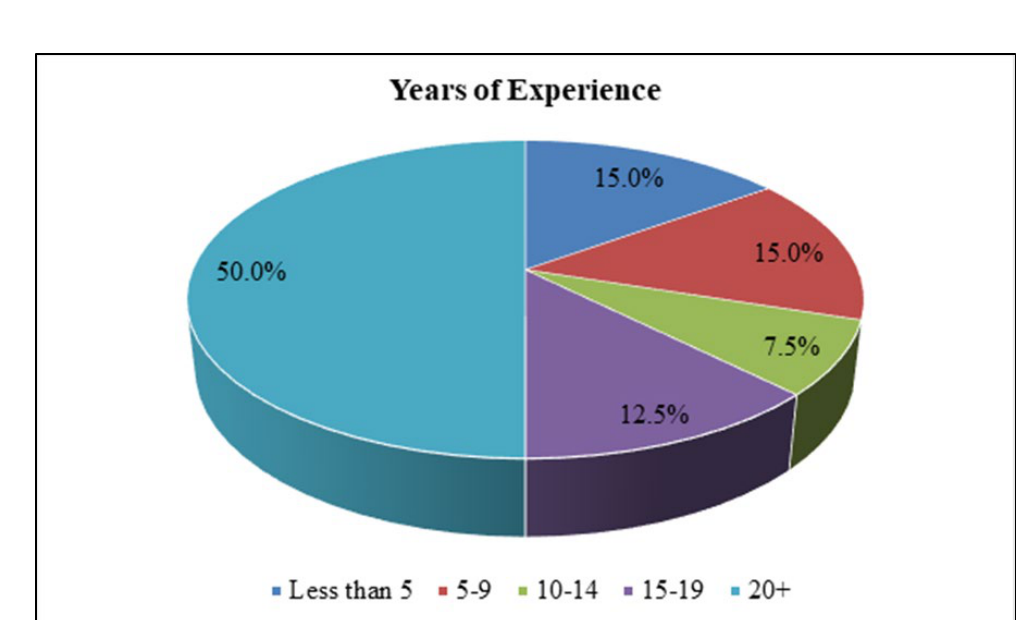
Figure 3 Frequency Distribution of Years of Experience (N=40) Figure 4 shows that four different library types were represented within the survey. 57.5% were currently working in a public library (n=23), 32.5% were working in an academic library (n=13), 5% were working in other (n=2), and 2.5% in either a school or vendor/publisher (n=1). For those working in an academic library, respondents reported